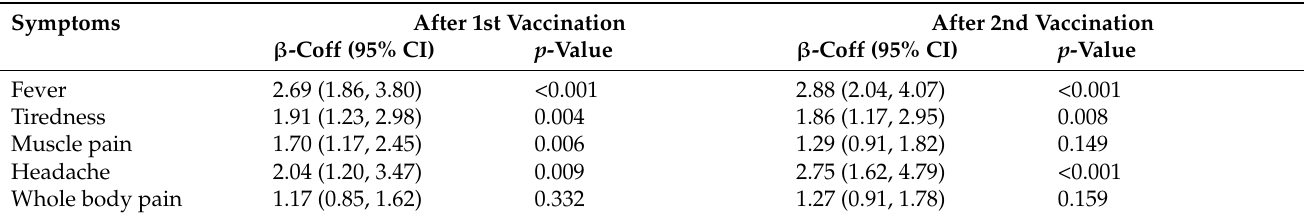
Table 1. Differences in antibody titers between participants with and without COVID-like symptoms after getting 1st and 2nd doses of COVID-19 vaccines.